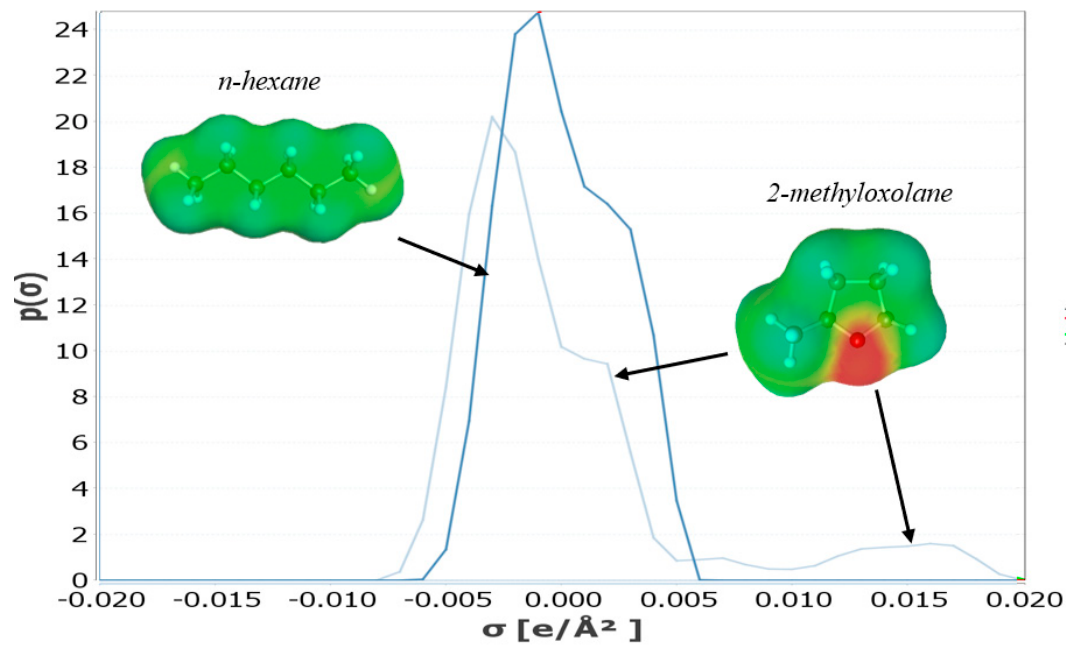
Figure 3. σ -surfaces and σ -profiles of 2-MeOx vs. n -hexane. Yellow / Red: molecule charge density < 0, Green: molecule charge density = 0 [36].